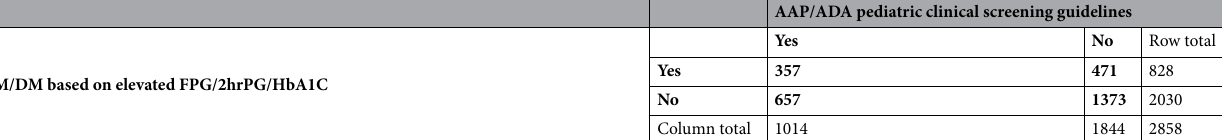
AAP/ADA pediatric clinical screening